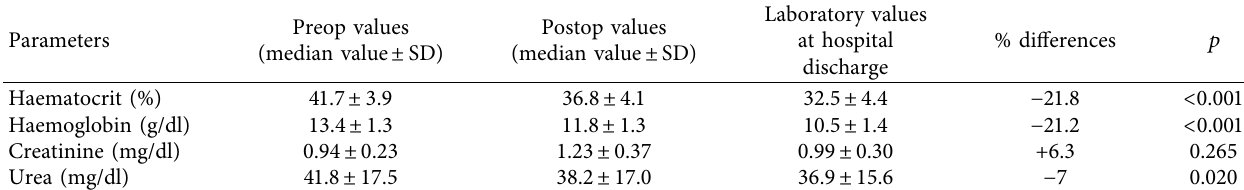
Table 2: Preoperative and postoperative laboratory fndings of the included population.